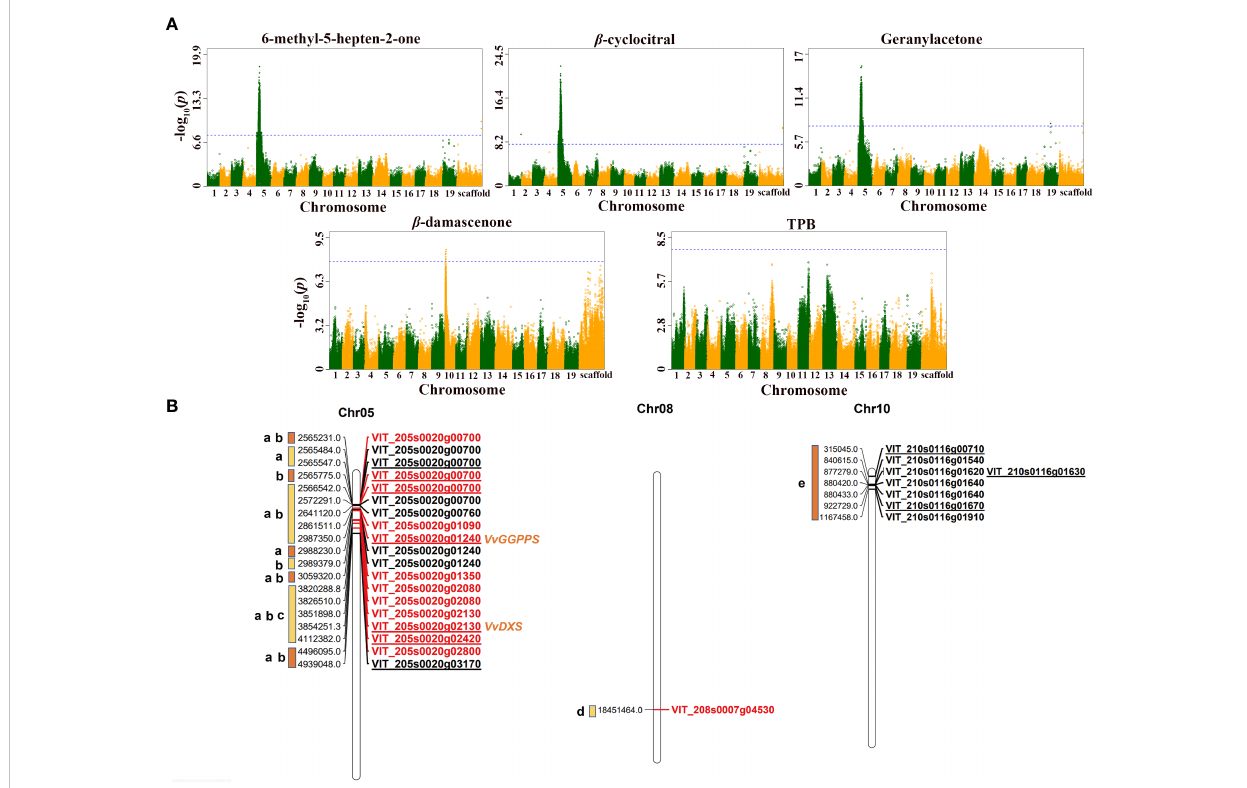
FIGURE 2 Genome-wide association analysis of fi ve norisoprenoid traits in grape berry. (A) Manhattan plots of fi ve norisoprenoid traits. The x-axis represents the position along a chromosome and the y-axis refers to the -log 10 ( P -value). Each point is the -log 10 ( P -value) of a SNP locus. The blue horizontal dashed line depicts the signi fi cance threshold, -log 10 (5e-8) =7.3. (B) Chromosomal location of main candidate genes. Different lowercase letters represent different traits: a, b, c, d, and e represent 6-methyl-5-hepten-2-one, b -cyclocitral, geranylacetone, TPB, and b -damascenone, respectively. The gene ID in red indicates that the gene has been veri fi ed later, and the underlined gene ID indicates that the locus was located in the coding region of the